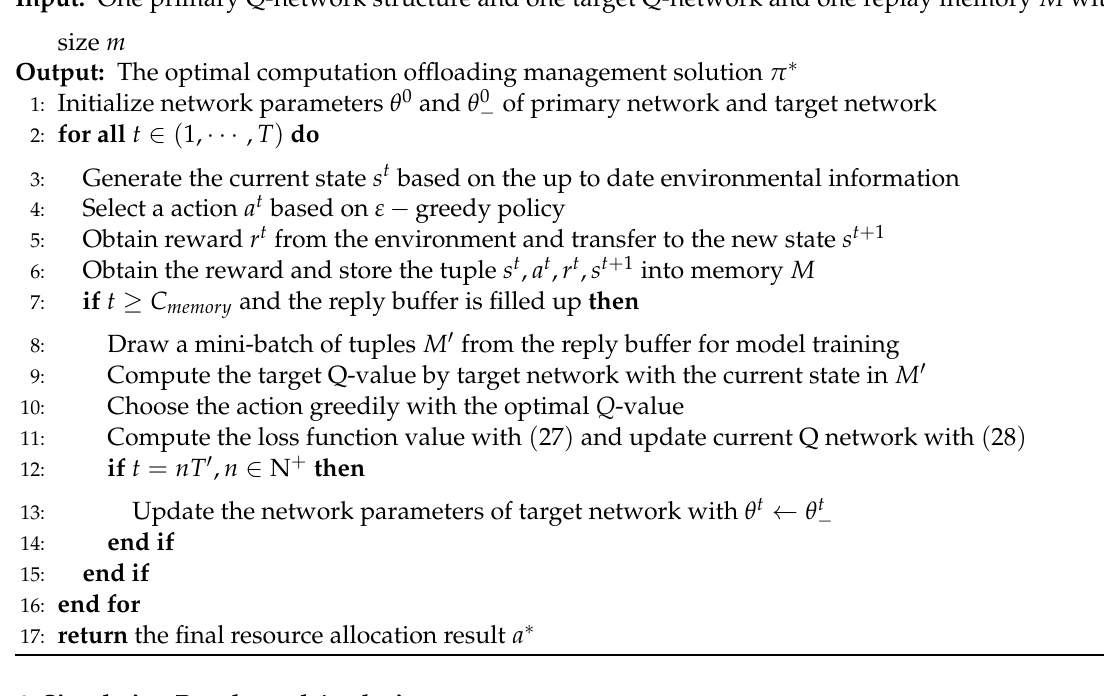
Algorithm 2 DDQN algorithm for Computation Offloading Management in a VCN